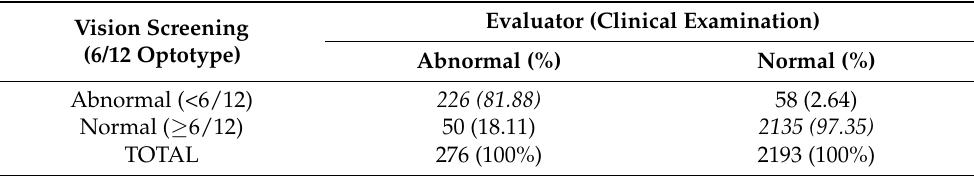
Table 5. Sensitivity and specificity of traditional vision screening. Figures in italics represent the sensitivity and